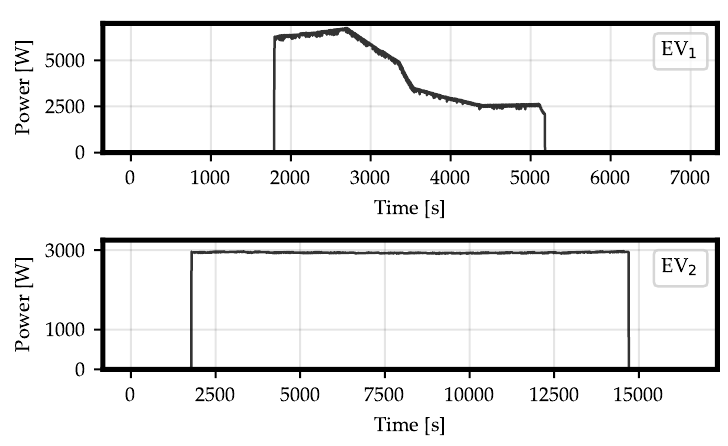
Figure 1. Active power curves during a charging process of both electric vehicles used in this paper in